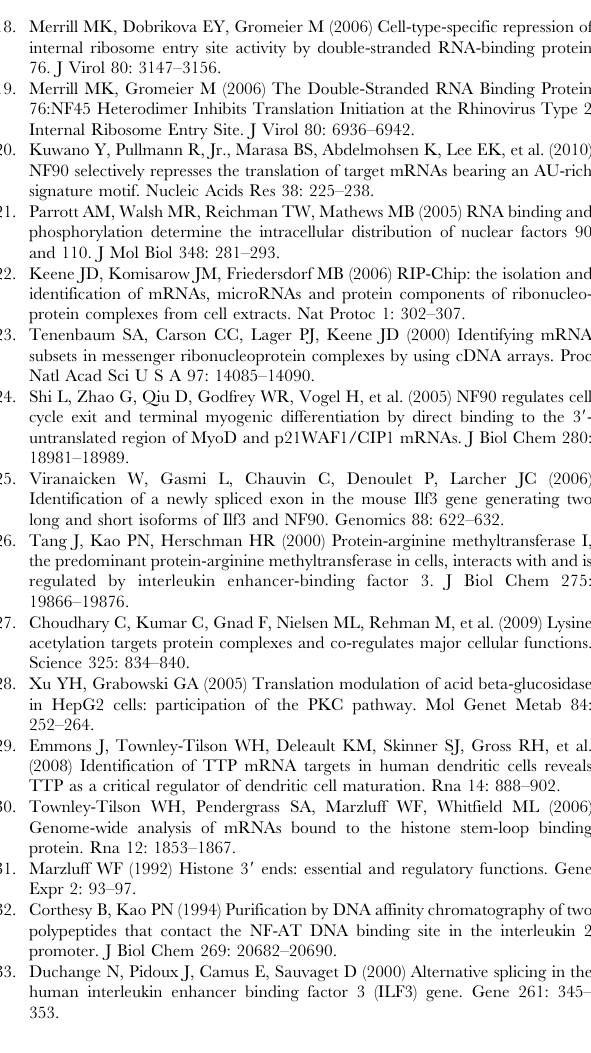
Figure S1 List of putative DRBP76 target mRNAs in HEK293 cells. XLS) Figure S2 Poly(I):(C) binding studies. Binding of DRBP76 proteins from HEK293 cells (top) and Cynomolgus brain lysates (bottom) to poly(I):(C) sepharose. Found at: doi:10.1371/journal.pone.0011710.s002 (0.59 MB